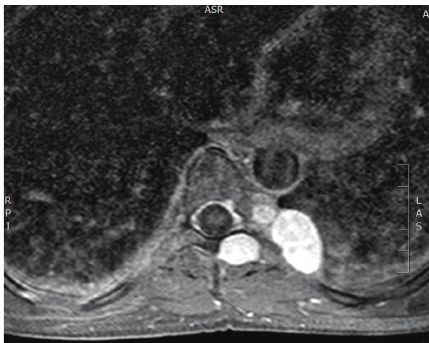
Figure 1: Magnetic resonance imaging (MRI) showing multiple paravertebral schwannomas.